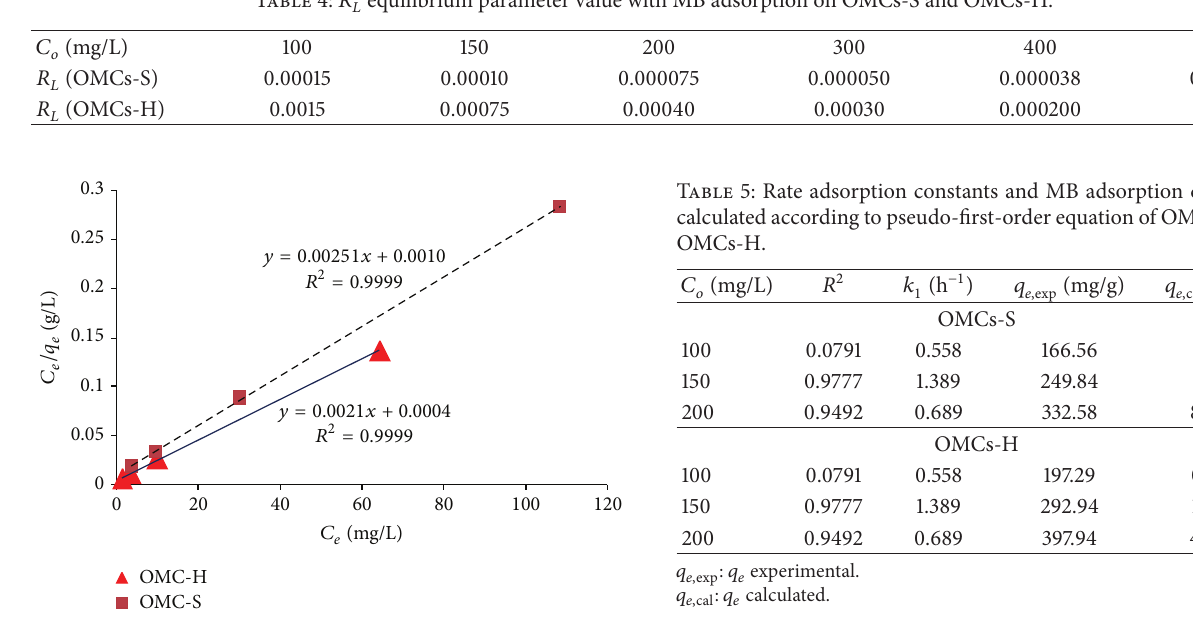
Figure 6: Comparison of MB adsorption capacity at different concentrations of OMCs-H (a) and OMCs-S (b). Table 4: 𝑅 𝐿 equilibrium parameter value with MB adsorption on OMCs-S and OMCs-H.